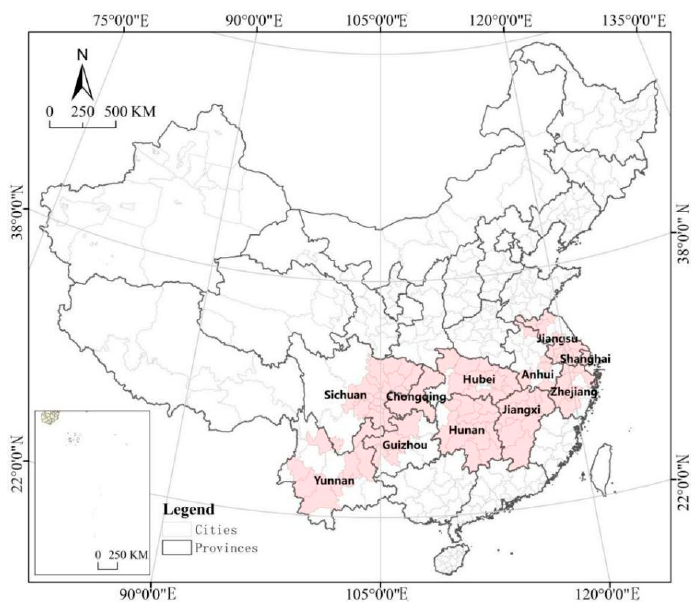
Figure 1. Study area.